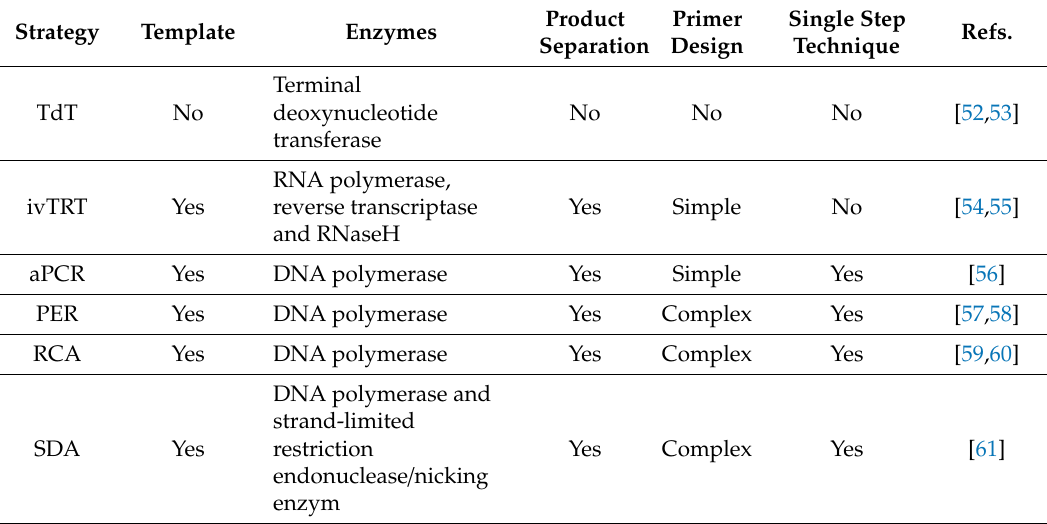
Figure 2. Schematic representation of enzymatic ssDNA synthesis. ( a ) The mechanism of terminal deoxynucleotide transferase (TdT)-based ssDNA synthesis; ( b ) The mechanism of transcription and reverse transcription; ( c ) The mechanism of asymmetric polymerase chain reaction (aPCR); ( d ) The primer exchange reaction (PER) cycle and mechanism for ssDNA synthesis; ( e ) The mechanism of rolling circle amplification (RCA). Table 1. Comparison of enzymatic methods for the synthesis of